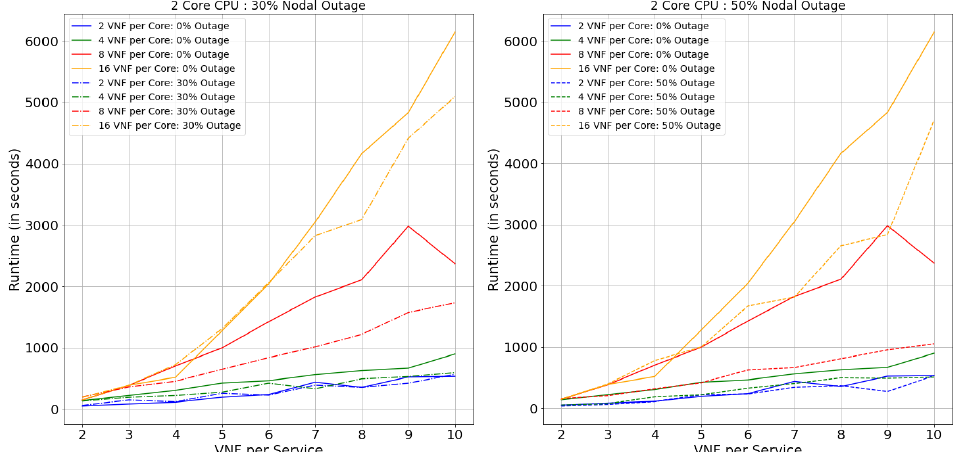
Figure 25. Runtime: BtEurope topology with nodal outage—2 core CPU.